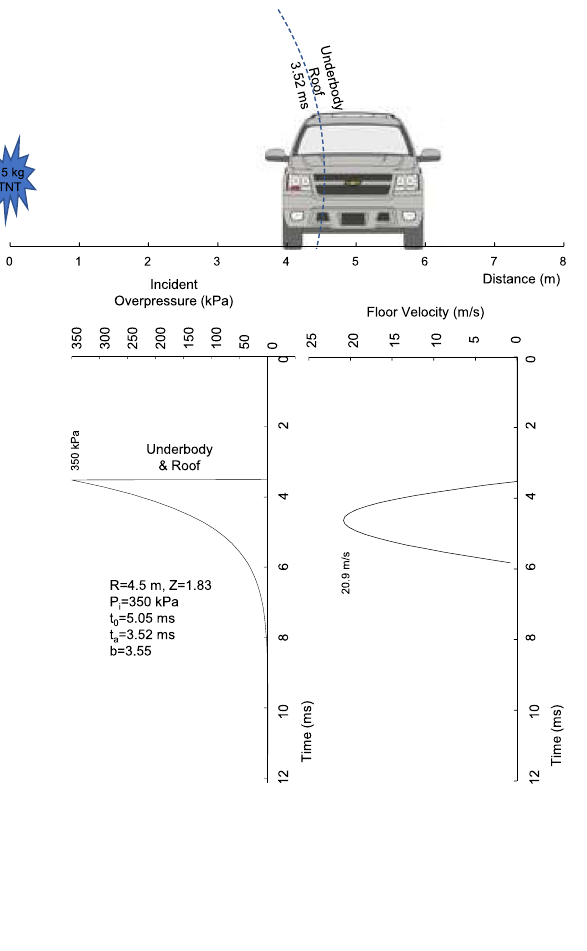
Figure 12. Underbody and roof loading of an armored passenger-vehicle with 4.5 m stand-off from 15 kg